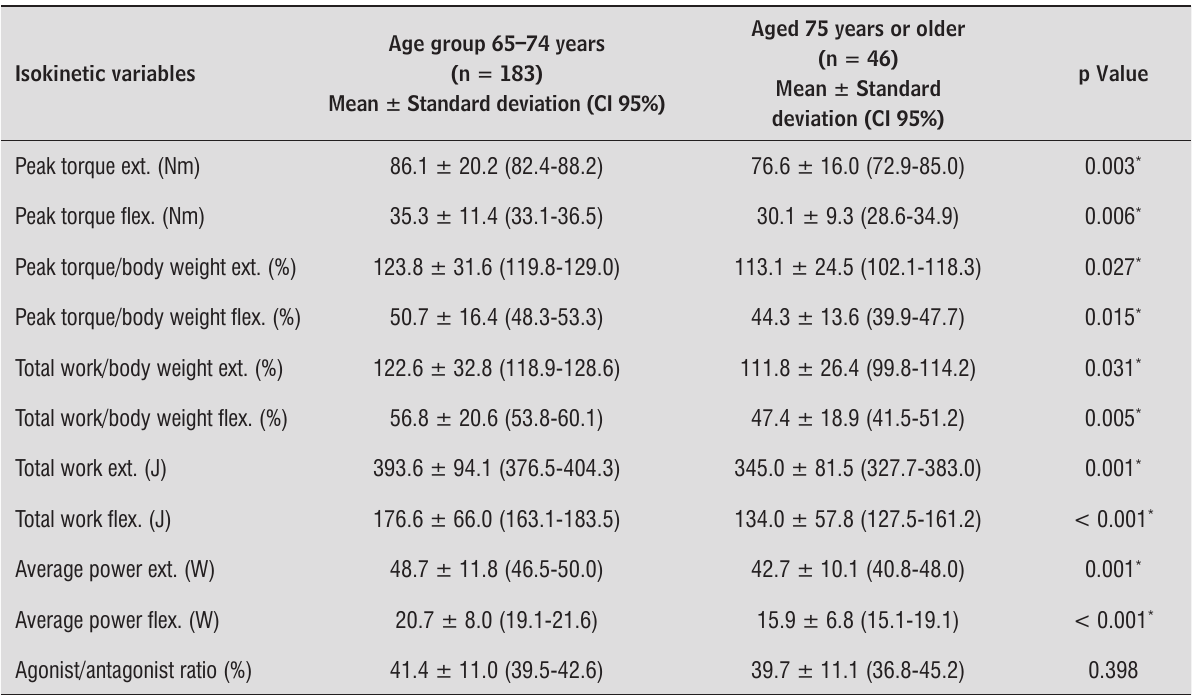
Table 2 - Values of the isokinetic variables for the extensors and flexors of the knee angular velocity of 60 °/s according to age group (n = 221)